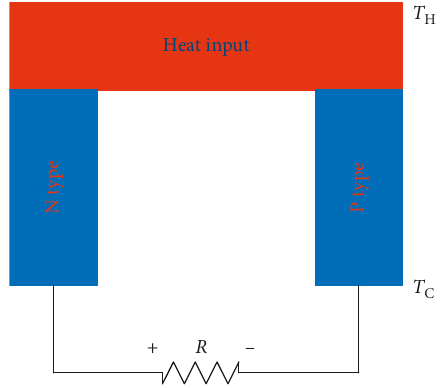
Figure 1: The schematic diagram of thermoelectric